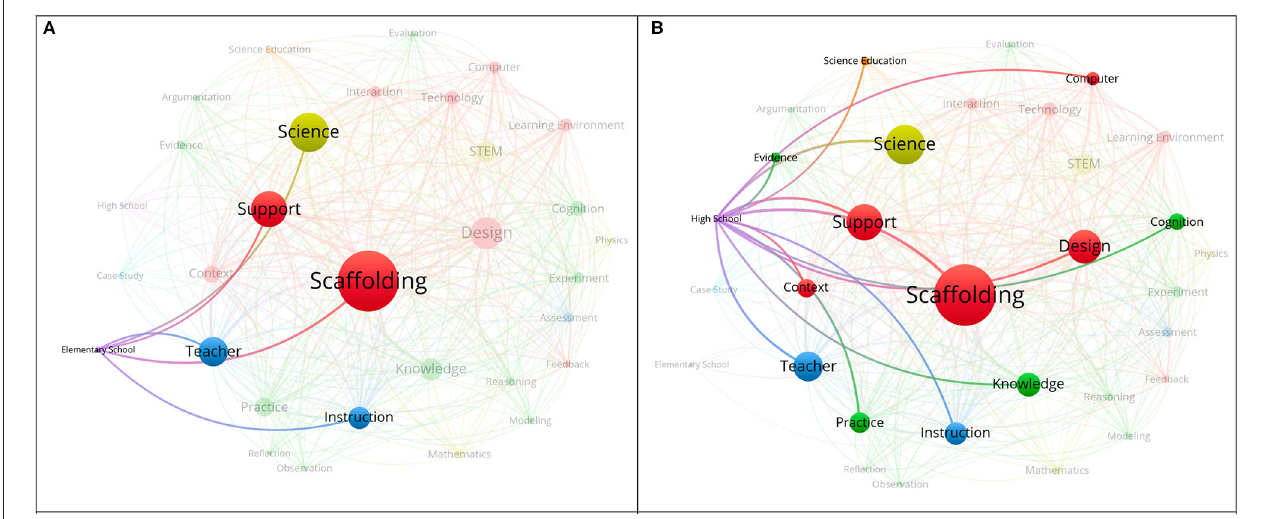
FIGURE 7 | (A) “Elementary school” and other frequently co-word network analysis (keywords = 5). (B) “High school” and other frequently co-word network analysis (keywords =